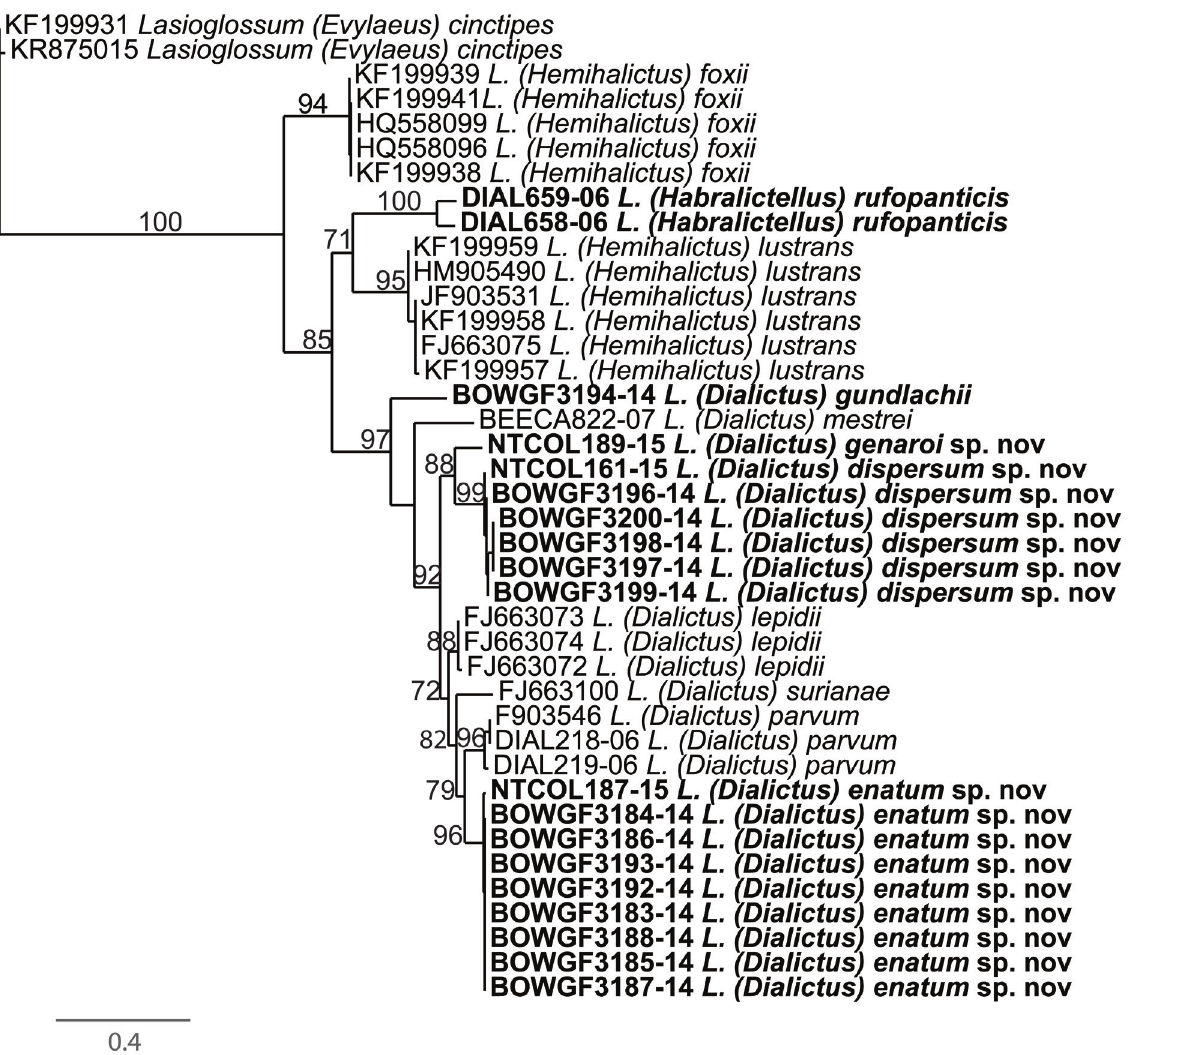
Fig. 1. Maximum-likelihood phylogeny of DNA barcode sequences of Puerto Rican Lasioglossum species (bold text) including extra-limital taxa for reference. Terminals include the species name with the GenBank accession or BOLD Process ID. Support values are not shown for intraspecific